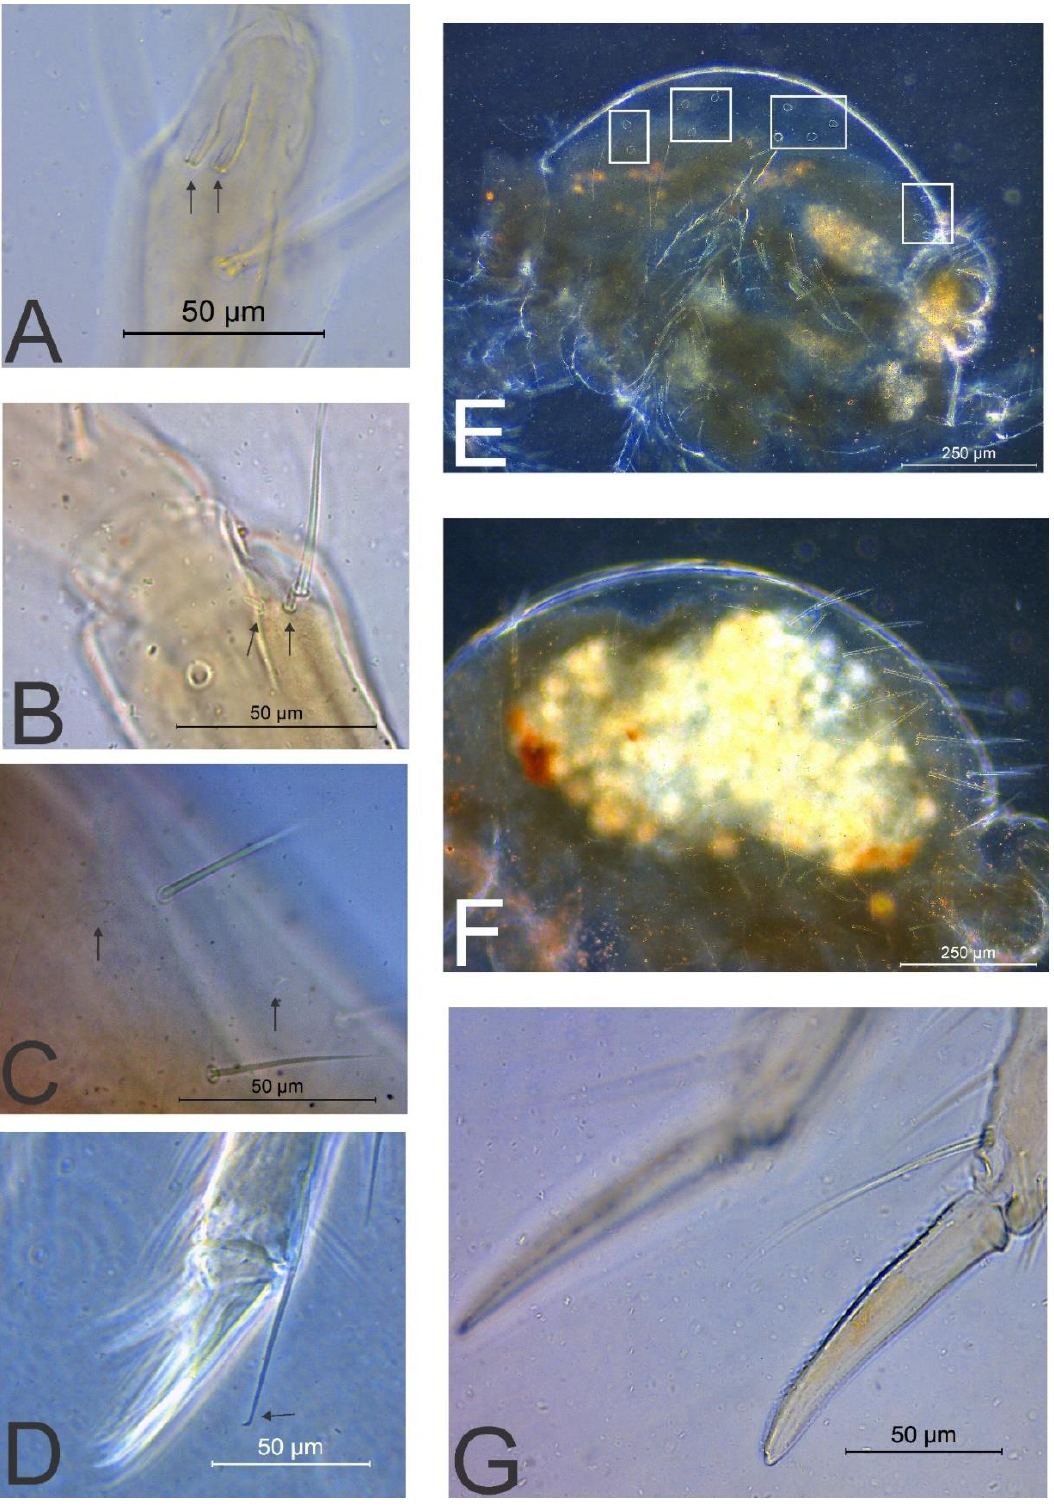
Figure 5. Richardsitas subferoleum sp. nov. photographs: ( A ) apex of Ant III, arrows point to apical organ sensory rods; ( B ) apex of Ant II, arrows point to small sensilla; ( C ) ventral head, arrows point to cuticular spines; ( D ) foot complex III, arrow points to capitate tenant-hair; ( E ) male large abdomen, squares highlight fields of short candle-shaped chaetae on dorsum; ( F ) female large abdomen; ( G ) mucro.